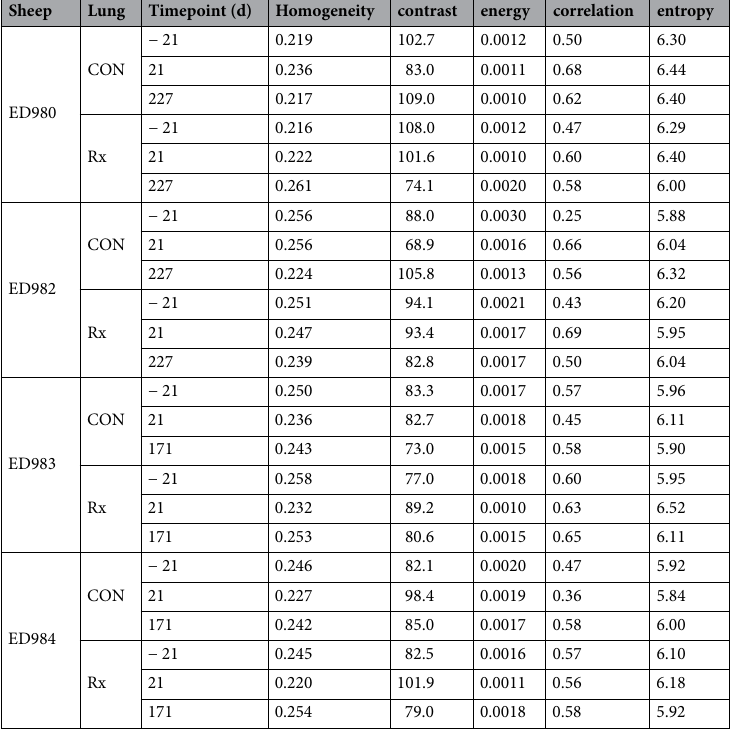
Table 4. Texture analysis statistics relating to grey level co-occurrence matrices derived from CT scan images of radio-exposed (Rx) and contralateral control (CON) lung at time points prior to (d-21), and following radiation exposure (d21, and d171/227).